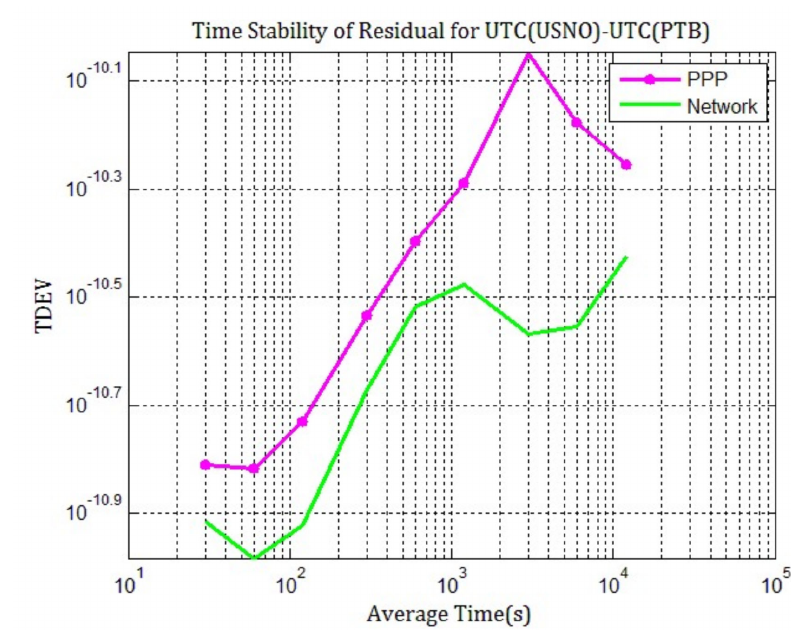
Figure 6. TDEV of the double-di ff erence for TAIPP with respect to PPP (purple), network solution (green), from MJD 58624 to 58633.